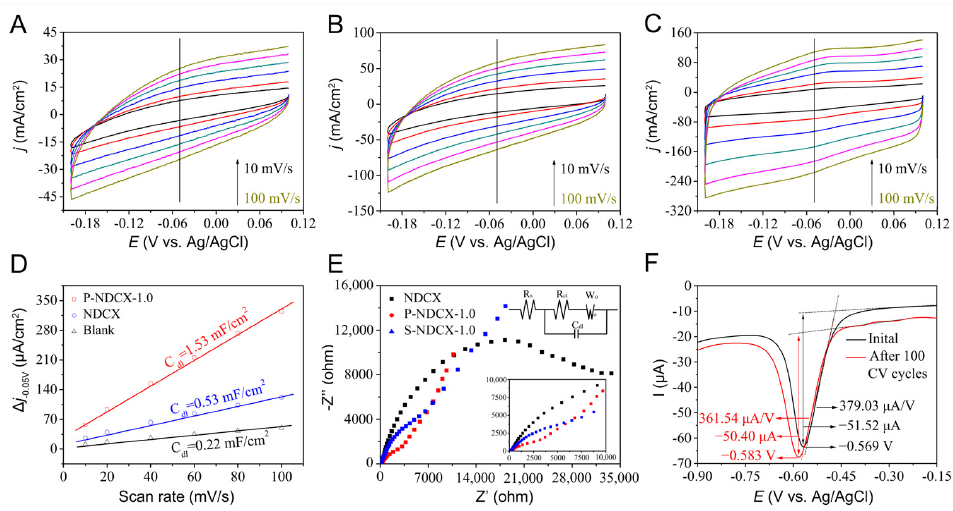
Figure 8. CV curves of ( A ) blank GCE, ( B ) NDCX, and ( C ) P ‐ NDCX ‐ 1.0 at different scanning rates in the non ‐ Faradic interval; ( D ) C dl of P ‐ NDCX ‐ 1.0 ( R 2 = 0.9992), NDCX ( R 2 = 0.9982), and blank GCE ( R 2 = 0.9975); ( E ) Nyquist plots of NDCX, P ‐ NDCX ‐ 1.0, and S ‐ NDCX ‐ 1.0; ( F ) The reduction peak curves of P ‐ NDCX ‐ 1.0 before and after 100 CV cycles.